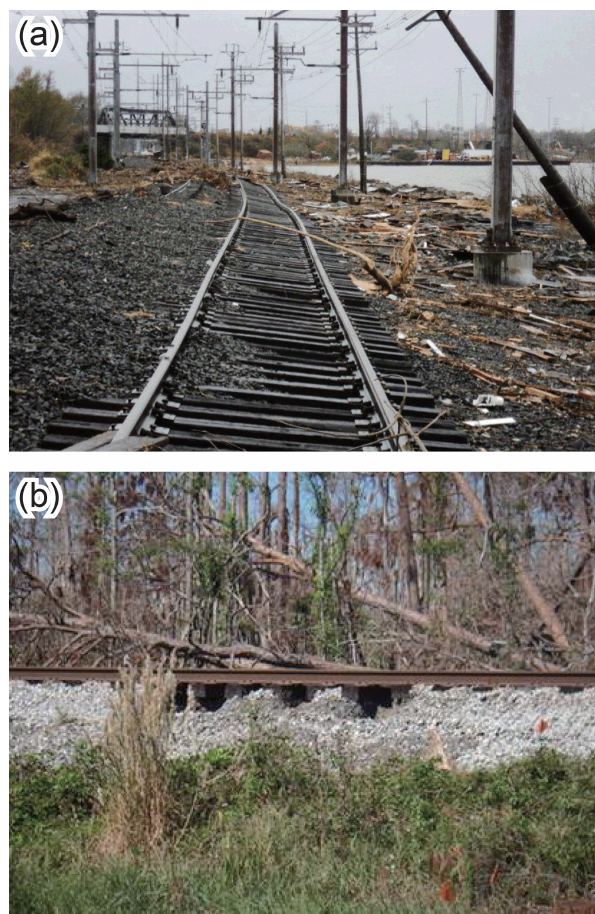
Figure 1. Railway ballast scour failures: ( a ) New Jersey Transit tracks in New Jersey, USA, after Hurricane Sandy in 2012; ( b ) CSX railroad tracks in Mississippi, USA, after Hurricane Katrina in 2005 (photo credits: New Jersey Transit, a